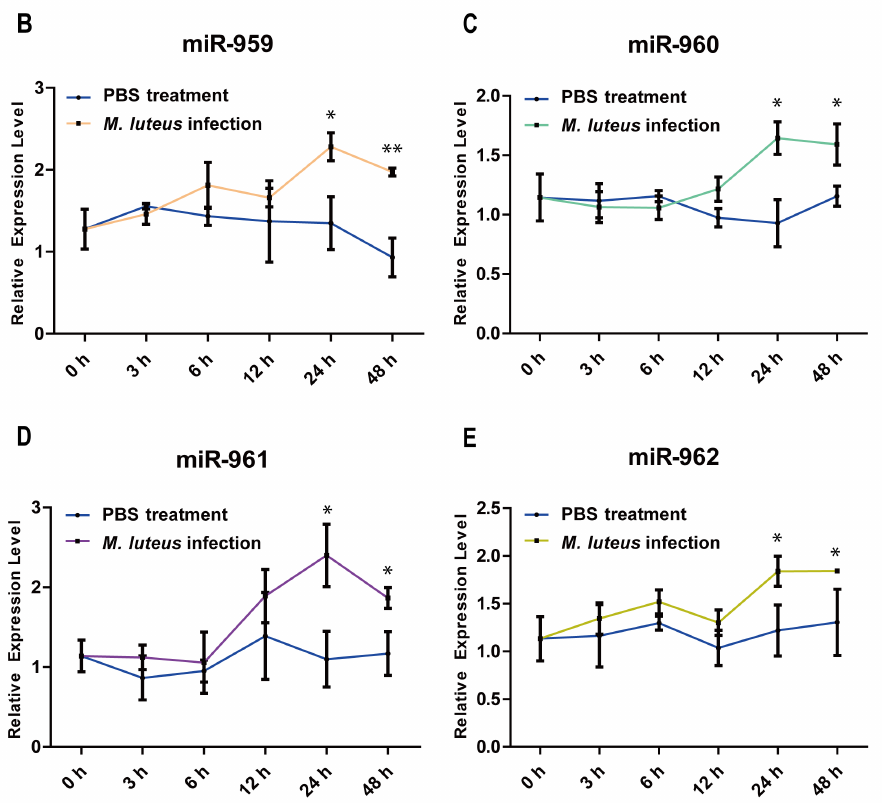
Figure 7. The temporal expression patterns of four miRNAs in the wild-type flies prior to and following M. luteus infection. The dynamic expression changes of Drs ( A ), miR-959 ( B ), miR-960 ( C ), miR-961 ( D ), miR-962 ( E ) at six time-points (0, 3, 6, 12, 24, and 48 h) prior to and following M. luteus or PBS infection, respectively. (* p < 0.05; ** p < 0.01; *** p < 0.001; and ns, no significance vs. the